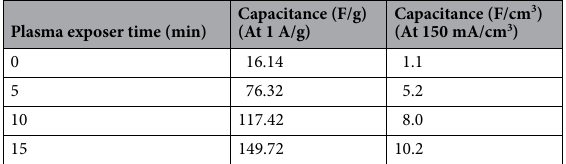
Plasma exposer time